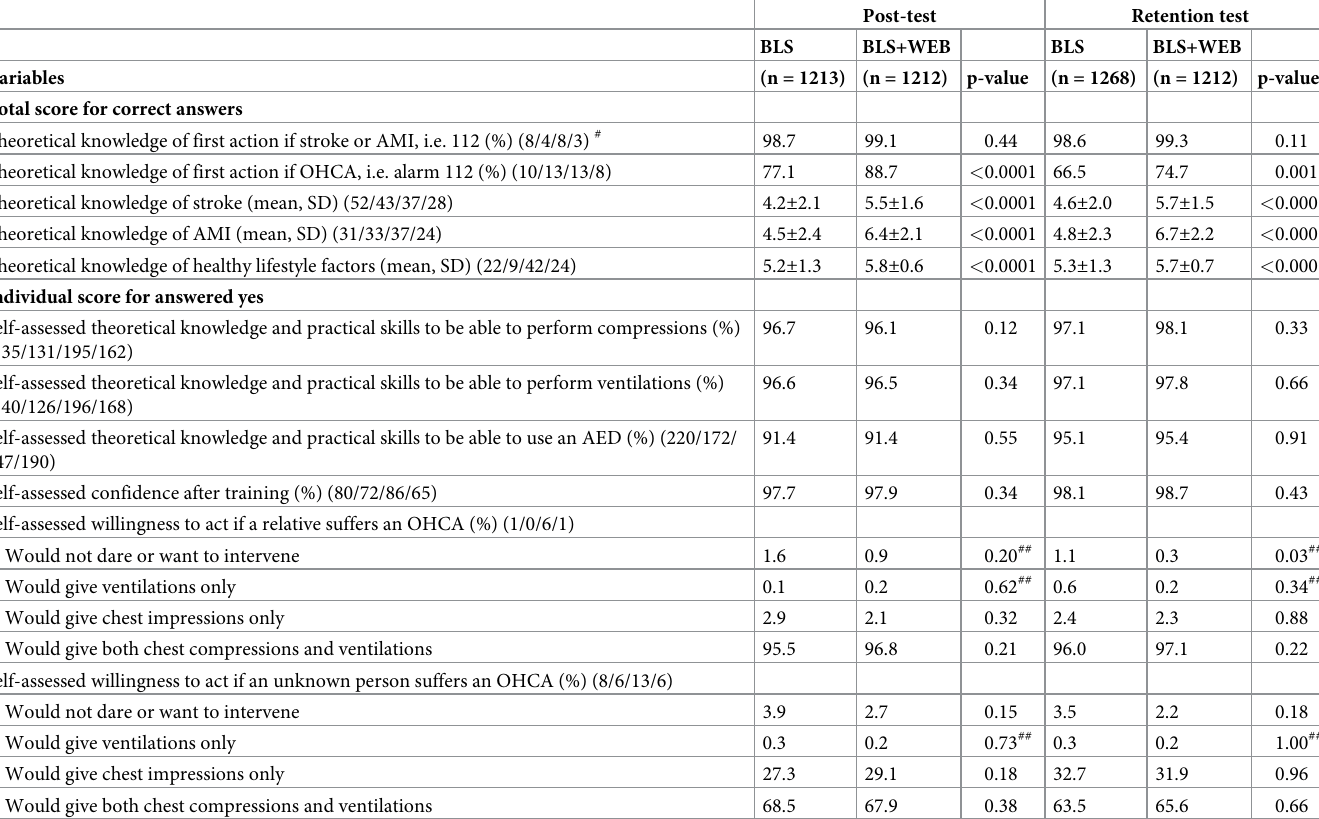
Table 4. Theoretical knowledge of cardiovascular disease (CVD), self-assessed theoretical knowledge, confidence and willingness to act in a real-life OHCA